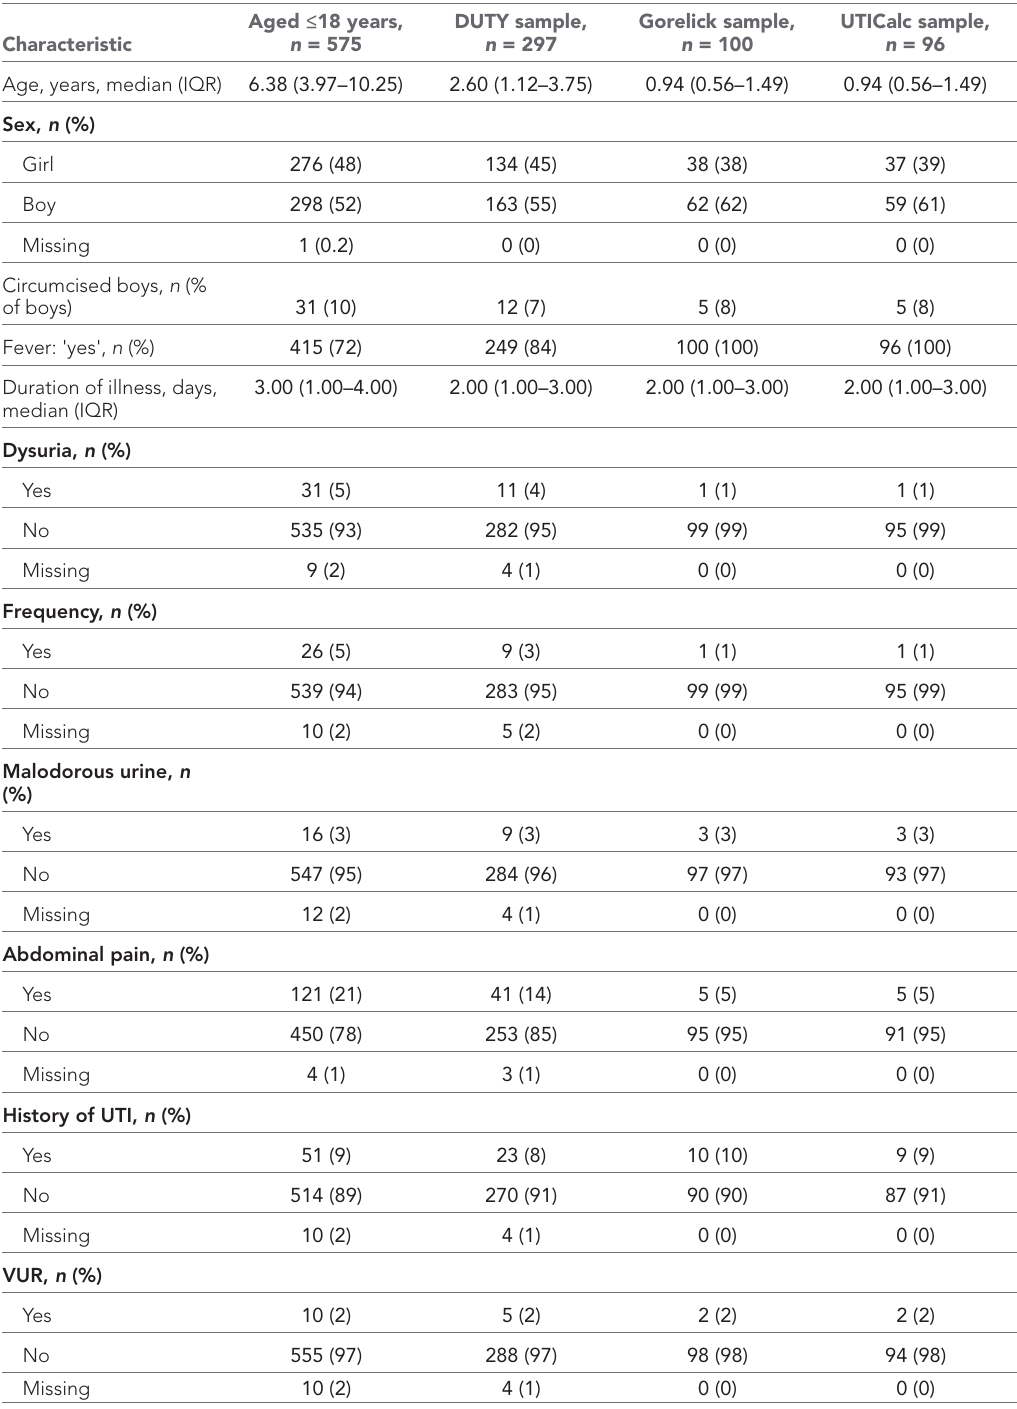
Table 2 Characteristics of acutely ill